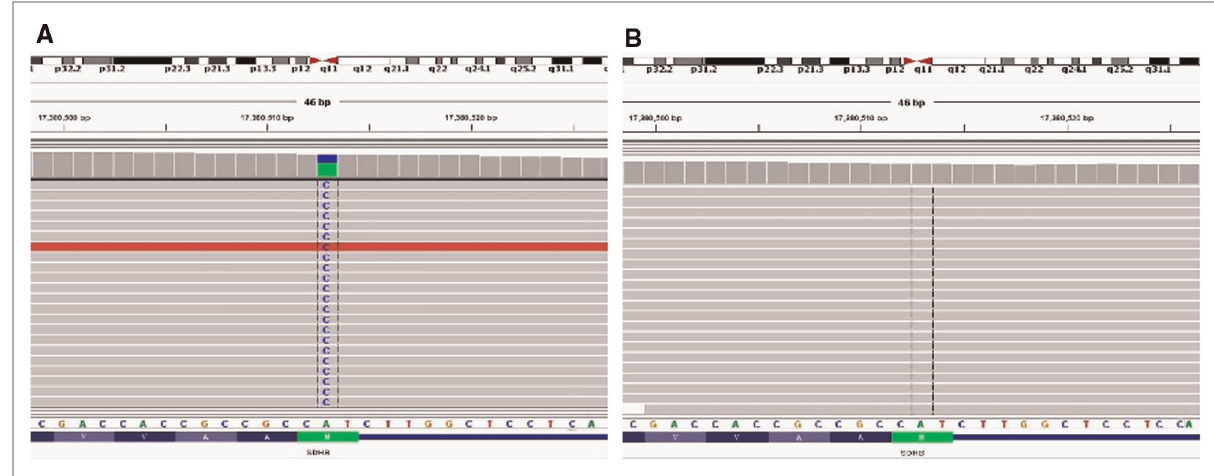
FIGURE 3 Comparison of tumor ( A ) and normal ( B ) FFPE samples. The SDHB gene somatic mutation (c.2 T>G, p.M1?) in exon 1 was detected by the